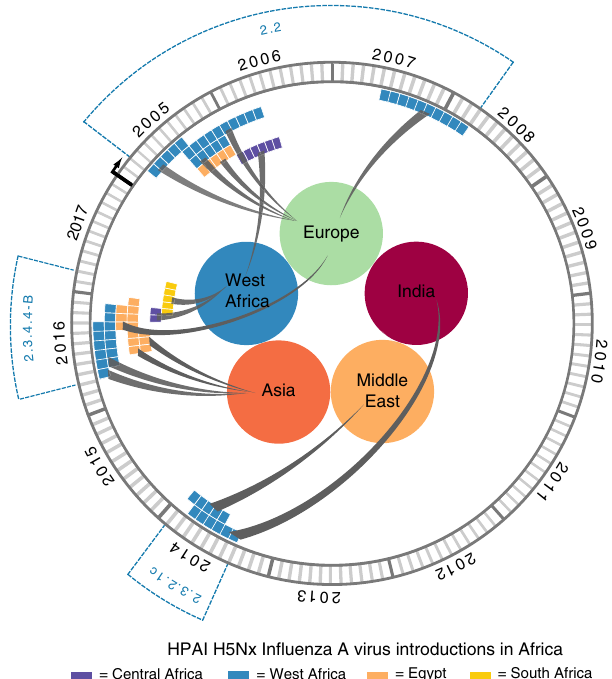
Fig. 3 tMRCA estimated for each virus introduction in Africa. Coloured bars represent the mean tMRCAs (Supplementary Table 2, Global dataset) of each virus introduction in West Africa (blue), Egypt (orange), East-Central Africa (violet) and South Africa (yellow). Circles represent the area of origin of each virus introduction, based on the estimates summarised in the maximum clade credibility trees of each HPAI H5 clade.